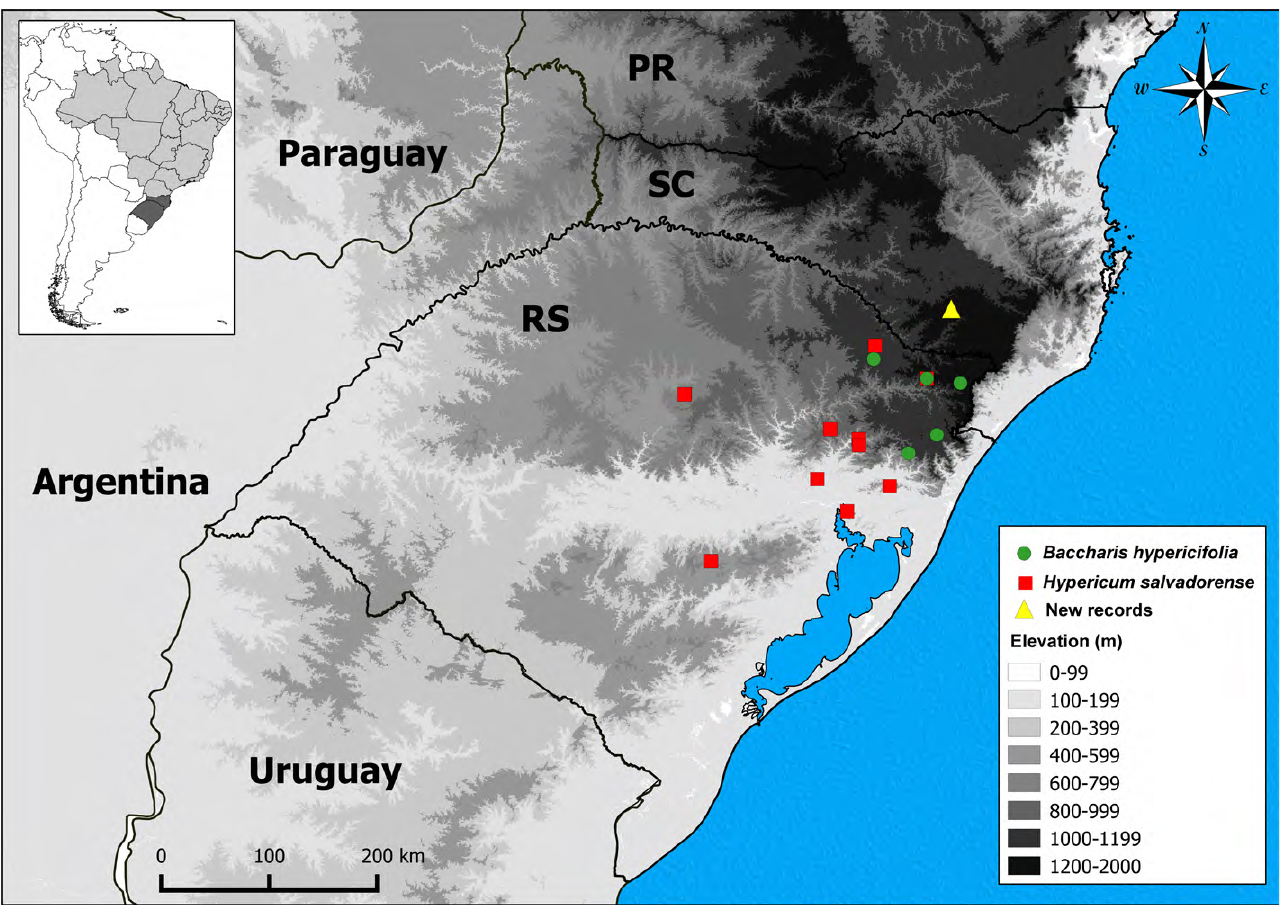
Figure 2. Geographic distribution of Baccharis hypericifolia and Hypericum salvadorense